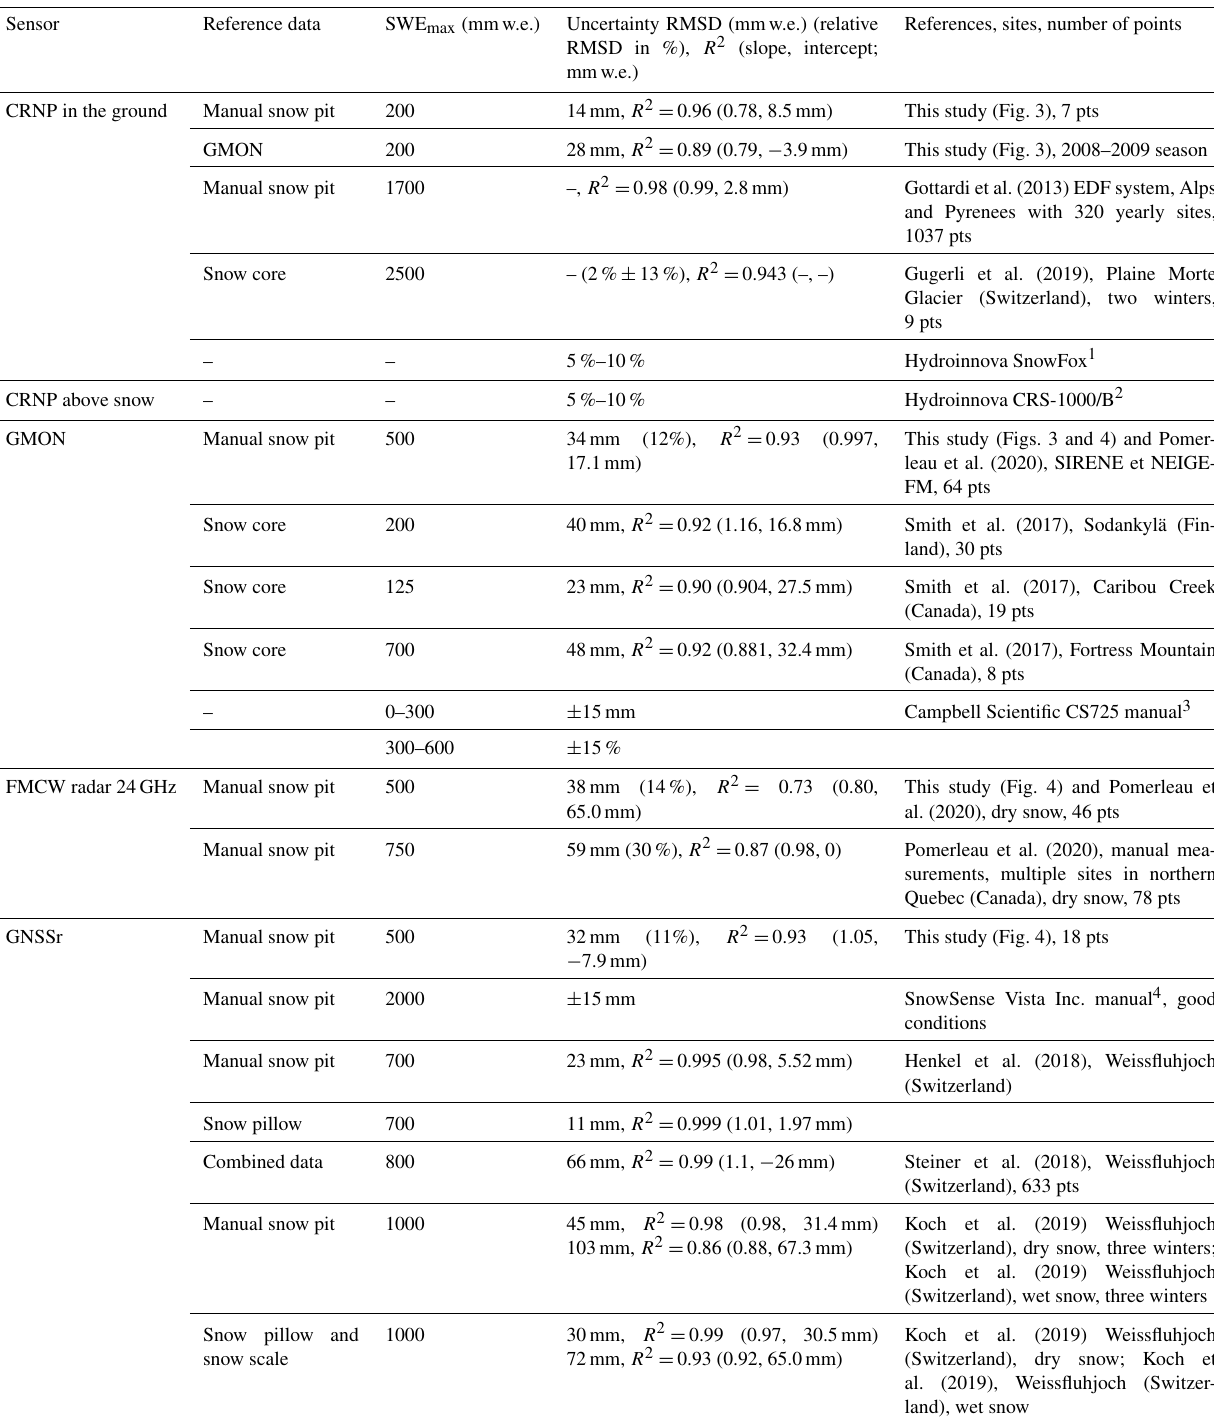
Table 2. Uncertainty analysis for the four systems that were considered. The range measurement indicates the highest SWE (mm) value on which the analysis was performed. RMSD: root-mean-square difference. R 2 : determination coefficient of the linear regression analysis. Pts: number of in situ manual samples. –: no information